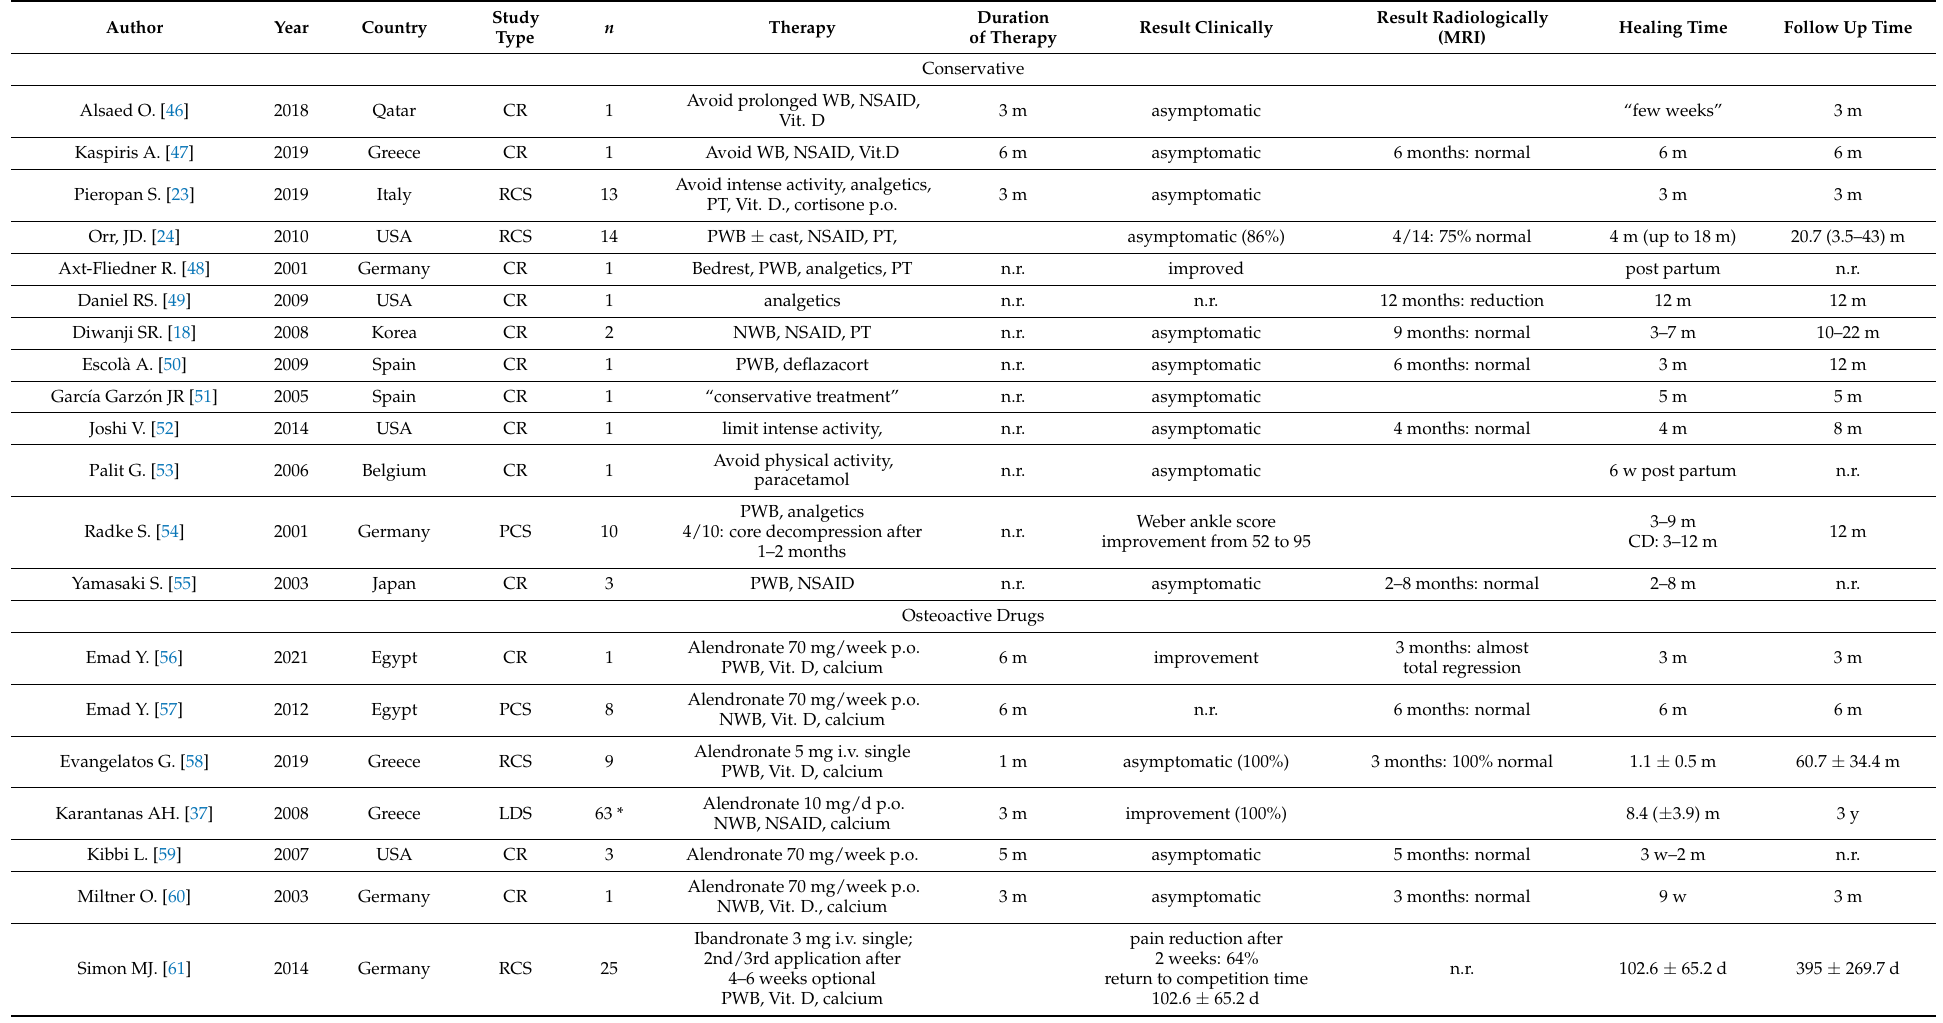
Table 2. Summary of all